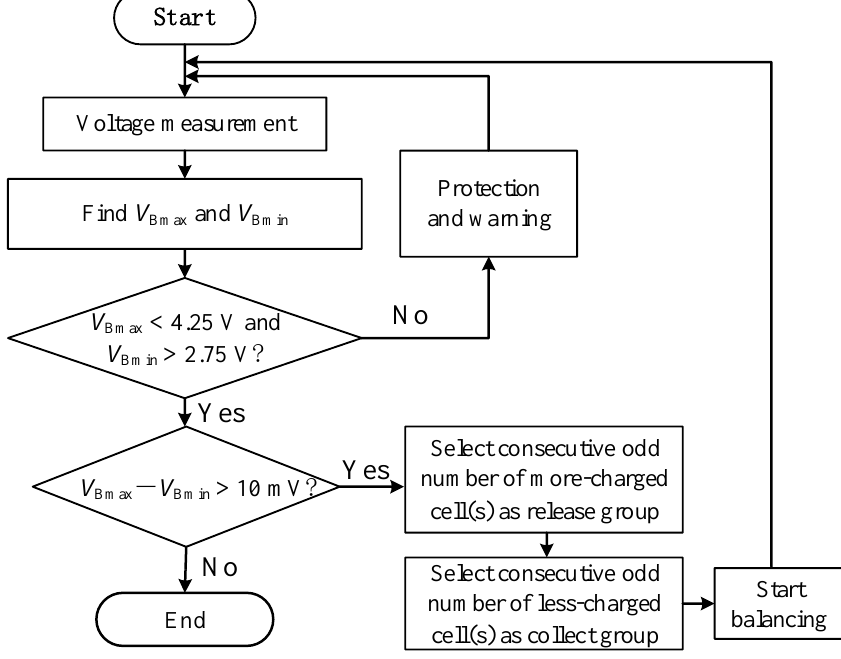
Figure 6. Control algorithm of the proposed FBBRLCC equalizer.